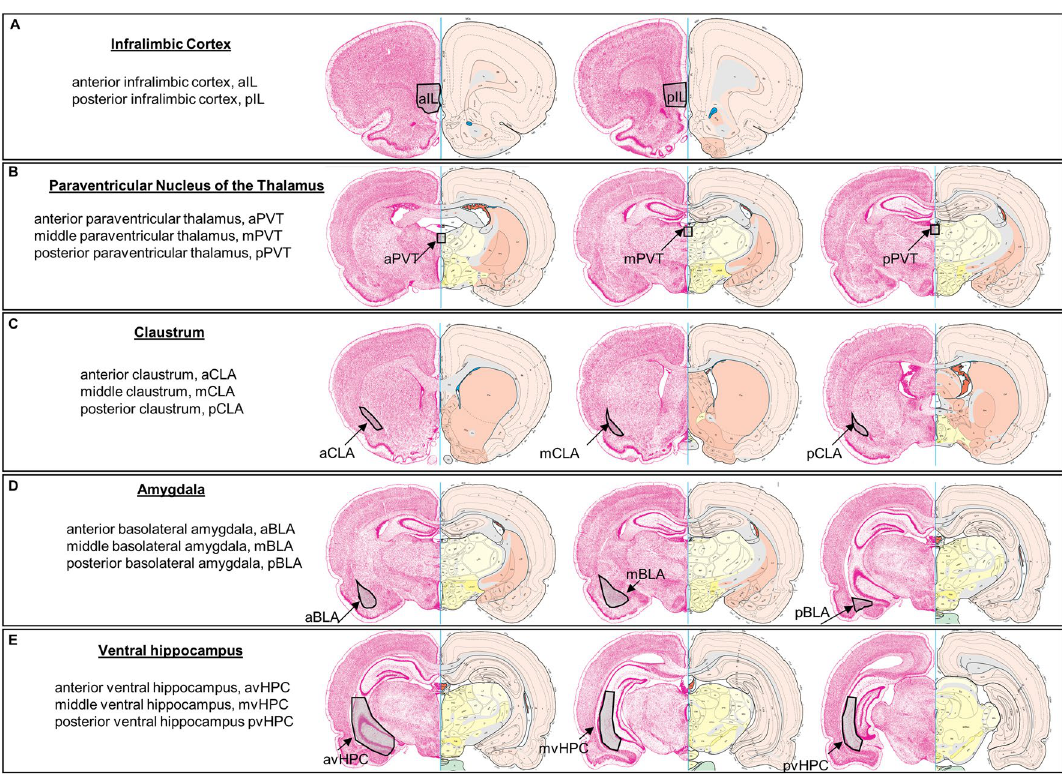
Figure 1. Abbreviations and locations of brain areas of interest. Explanation of abbreviations and locations for brain areas referenced throughout the manuscript. The open access brain maps are reproduced from Swanson (2004) Brain maps: structure of the rat brain, 3rd edition; under the terms of a Creative Commons Attribution- Non Commercial 4.0 International License (https:// creat iveco mmons. org/ licen ses/ by- nc/4. 0/) and are available for download at https:// larry wswan son.